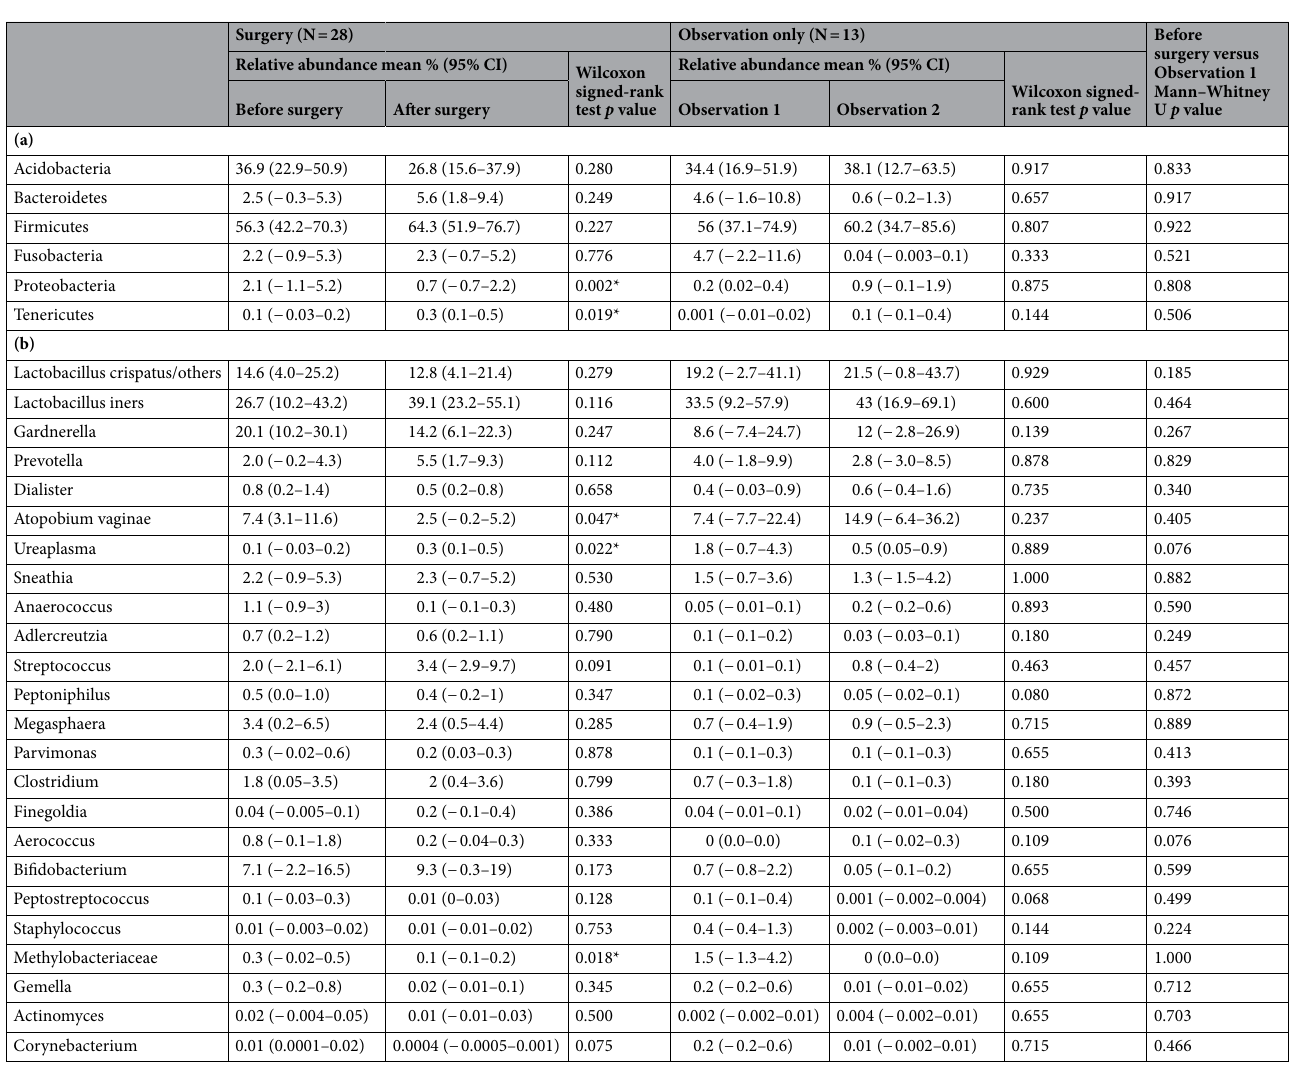
Table 3. Relative abundance of microbiota; (a) phyla and (b) genus over time. * p < 0.05 by Wilcoxon signed- rank test.